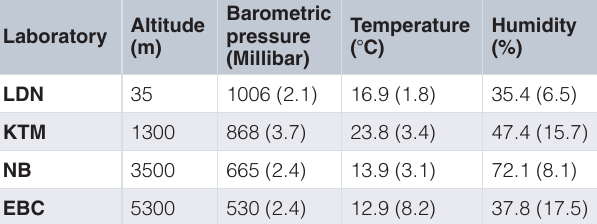
Table 2. Mean (±SD) altitude, barometric pressure, temperature and humidity at each XE2 laboratory. Key: LDN = London, KTM